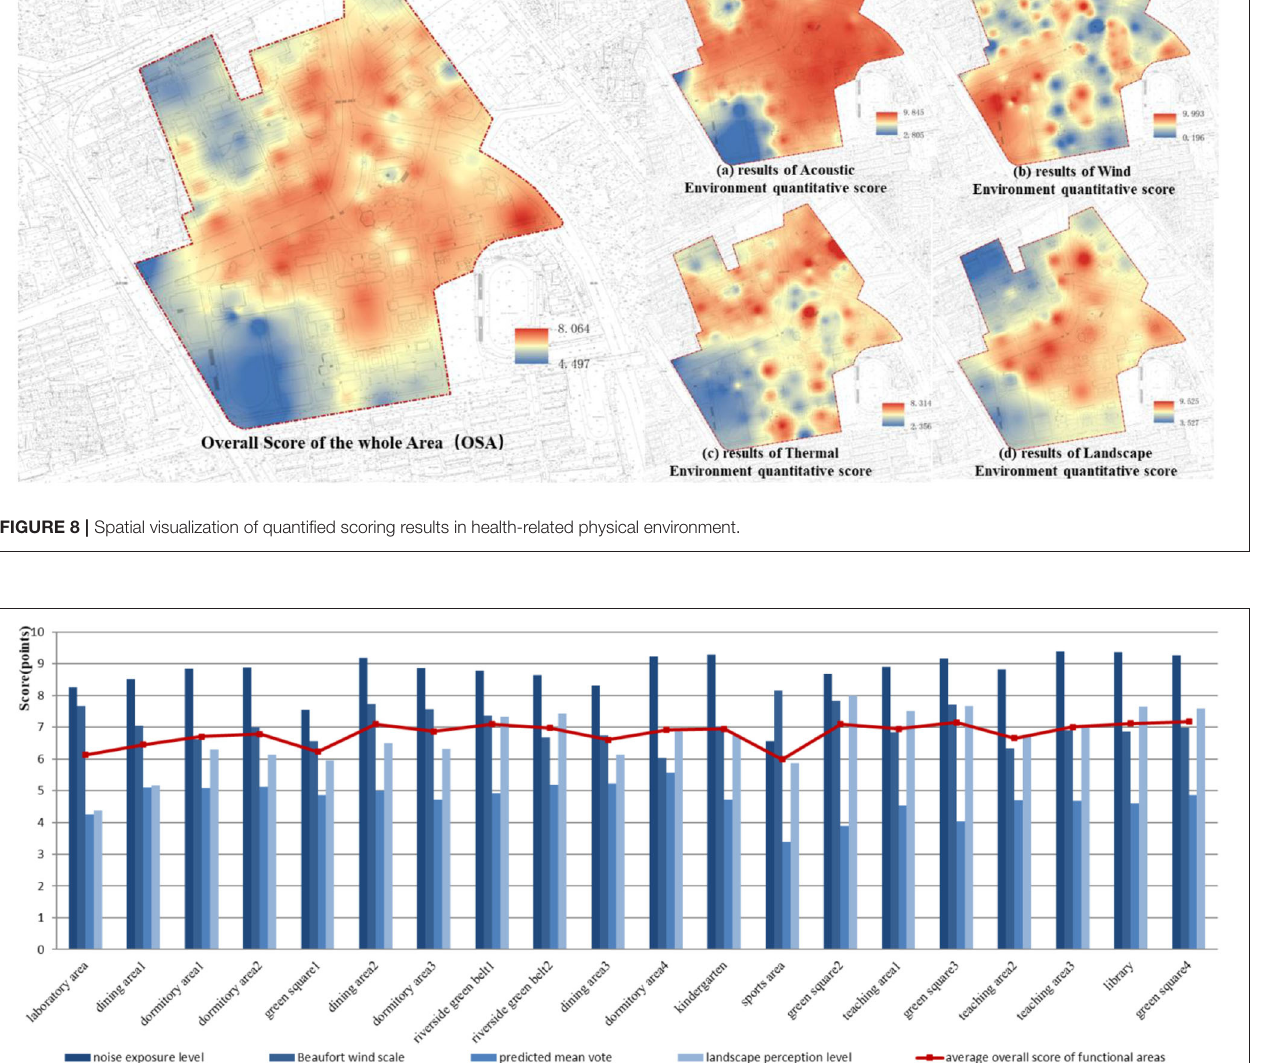
FIGURE 9 | Quantitative scoring results of the health-related physical environment in each zone.